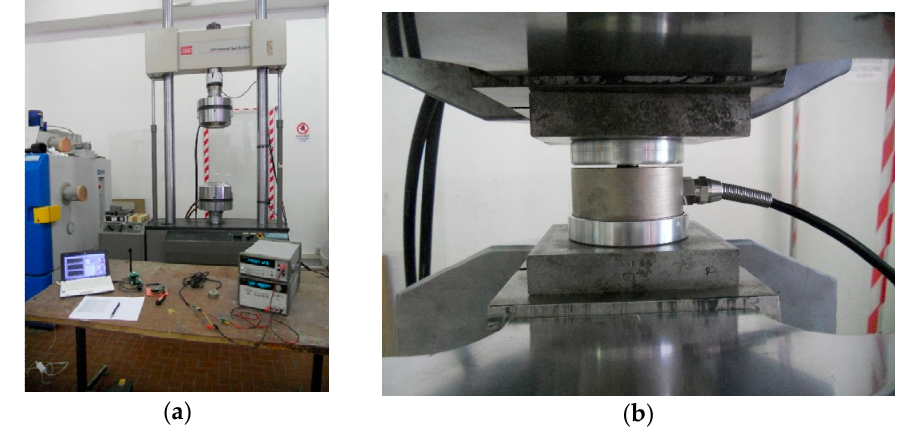
Figure 6. Load cell test set-up, free air: ( a ) experimental setup, including the MTS hydraulic press, and ( b ) detail of the LC under test.